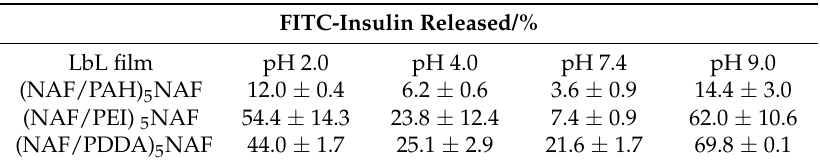
Table 2. Amount of FITC-insulin released from LbL